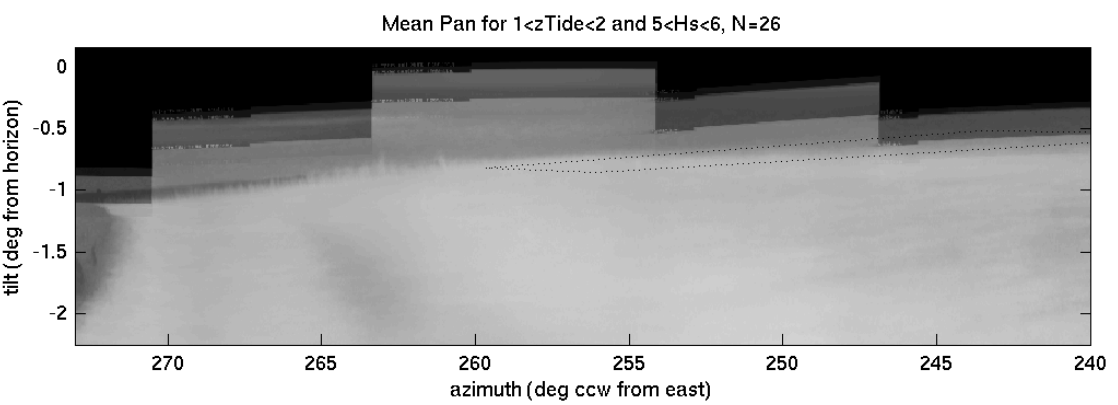
Figure 7. Example of averaged pan “brightest” image for the 26 images for which the tide elevation was between 1 and 2 m and the wave height was between 5 and 6 m. Breaking for very large wave heights appears to saturate across the full surf zone.